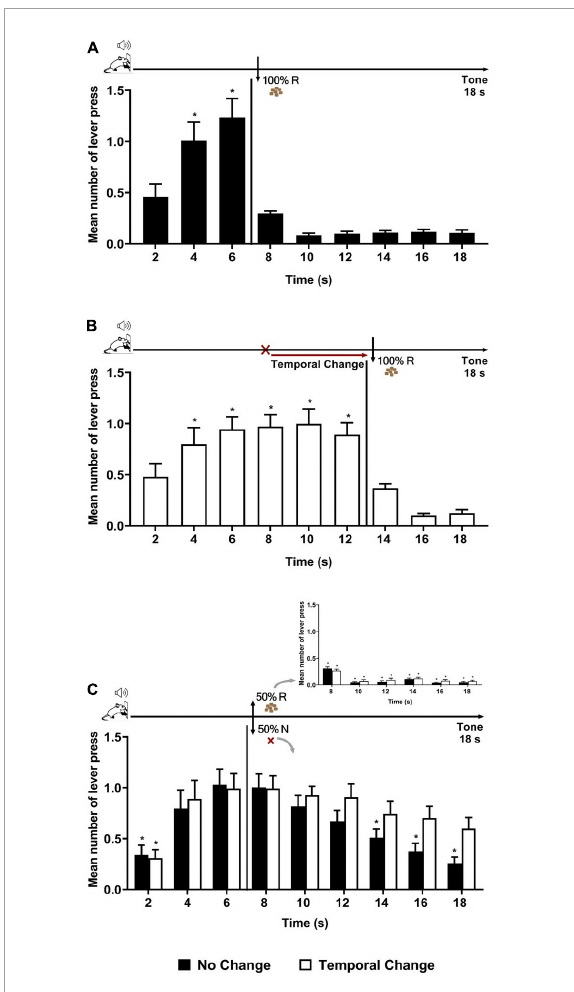
FIGURE1 Temporal prediction error generated a long-lasting memory updating of temporal expectancy. Responses average (+ SEM) during the 18-s tone, per 2 s, for No Change (Black columns; n = 14) and Temporal Change (White Columns, n = 13) groups. (A) Error session of No Change Group during FI 6 s LH 12 s signaled schedule (* p < 0.05, post hoc intra-group differences from 2 s). (B) Error session of Temporal Change group during FI 12 s LH 6 s signaled schedule during which the FI time was changed from 6 to 12 s to obtain the reinforcement (* p < 0.05, post hoc intra-group differences from 2 s). (C) Test session of reinforcement omission effect (ROE) during FI 6 s LH 12 s signaled schedule in which the reinforcement was omitted in 50% of trials (* p < 0.05, post hoc intra-group differences from 6 s). FI: fixed-interval; LH: limited hold; R: Reinforcement; N: